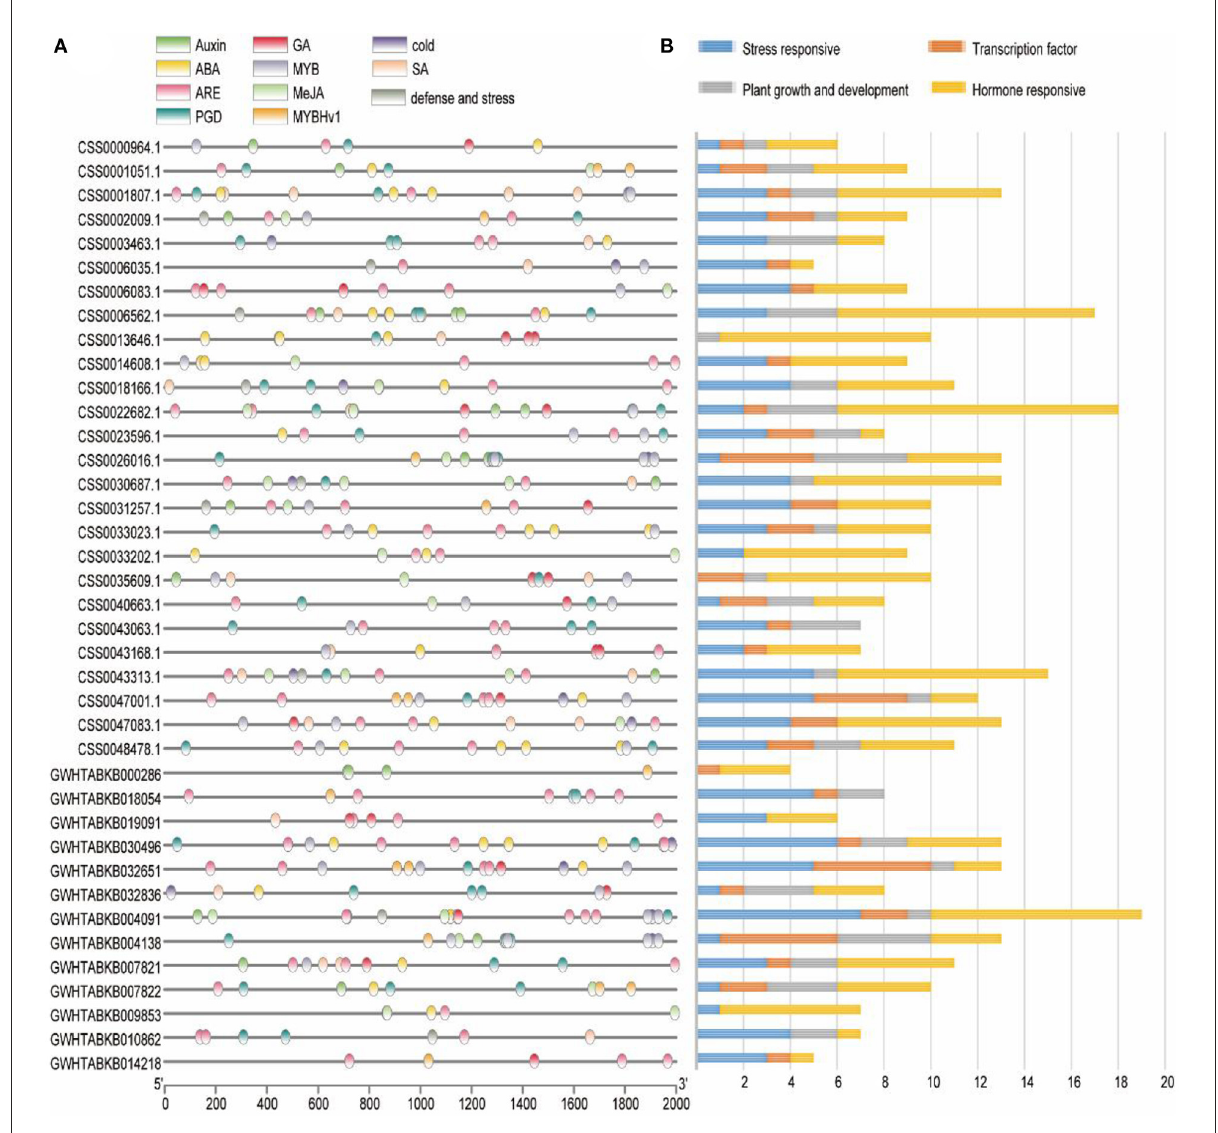
FIGURE3 Analysis of cis-regulatory element distribution in the OVATE promoters. (A) The cis-elements in the OVATE were marked by different colors. (B) The number of cis-elements numbers in four